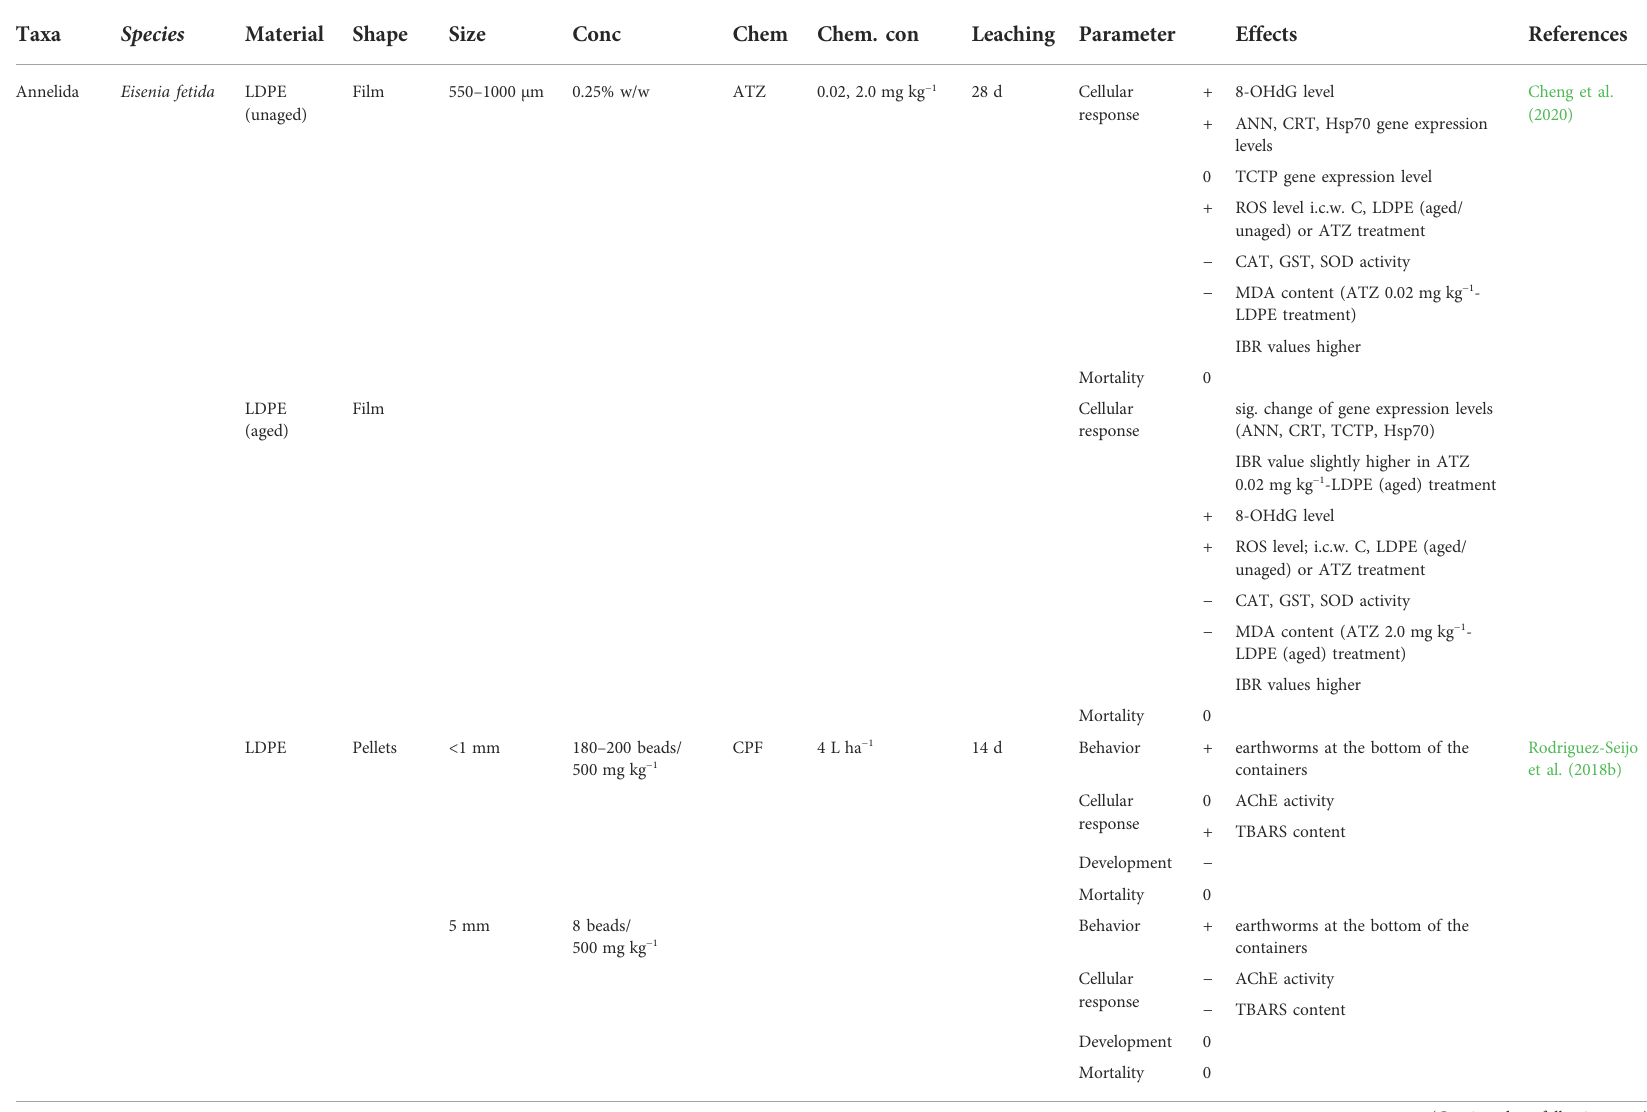
TABLE 6 In fl uence of microplastics on the bioavailability of environmental chemicals in soil invertebrates.